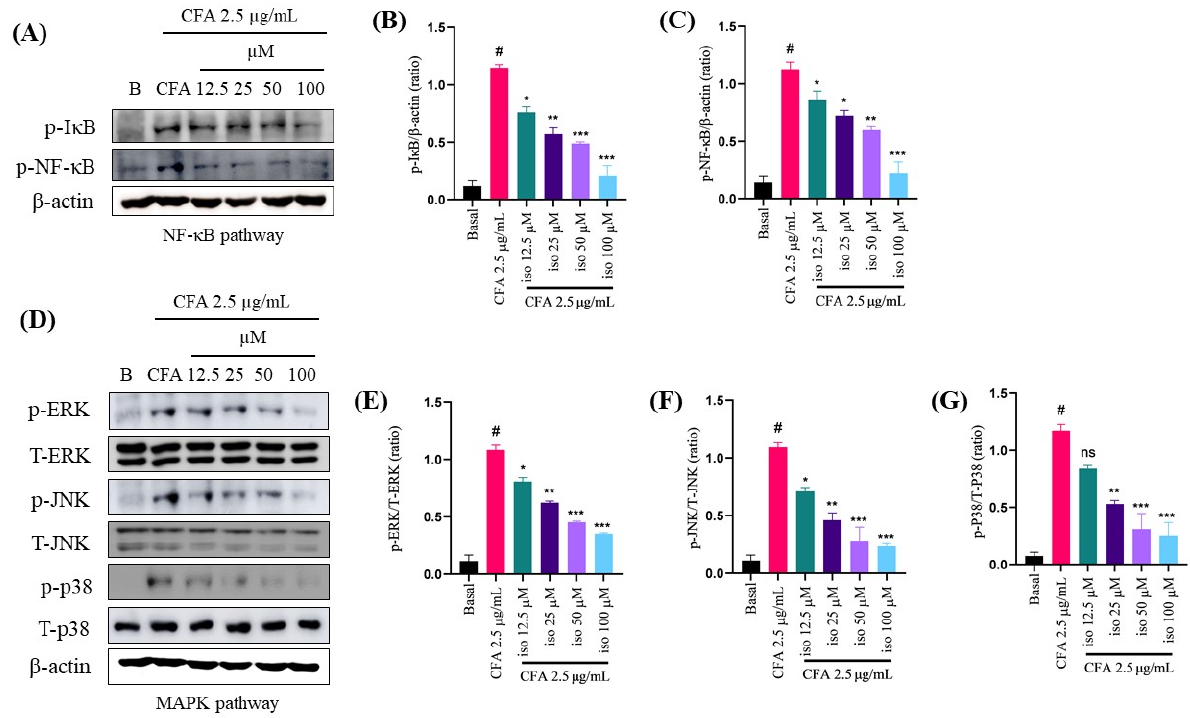
Figure 5. Effect of isoleucilactucin on CFA-induced NF- κ B and mitogen-activated protein kinase (MAPK) pathways in MH-S cells measured by Western blotting. ( A ) Western blot analysis was done to evaluate the protein levels of the phosphorylated (p)-I κ B and p-NF- κ B pathways. ( B , C ) ImageJ was used to perform densitometric analysis of the protein expression levels. ( D ) Western blotting was used to investigate the MAPK pathways, which includes ERK, JNK, and p38. ( E – G ) ImageJ was used to perform densitometric analysis of the protein expression levels. As a loading control, β -actin was used. Isoleucilactucin dosages of 12.5, 25, 50, and 100 μ M were used on cells seeded in a 6-well plate. Values from the three independent experiments were expressed as the mean ± SEM ( n = 3). Compared with the basal group, # p < 0.001; compared with the CFA group, ns: not significant, * p < 0.05, ** p < 0.01, and *** p < 0.001.